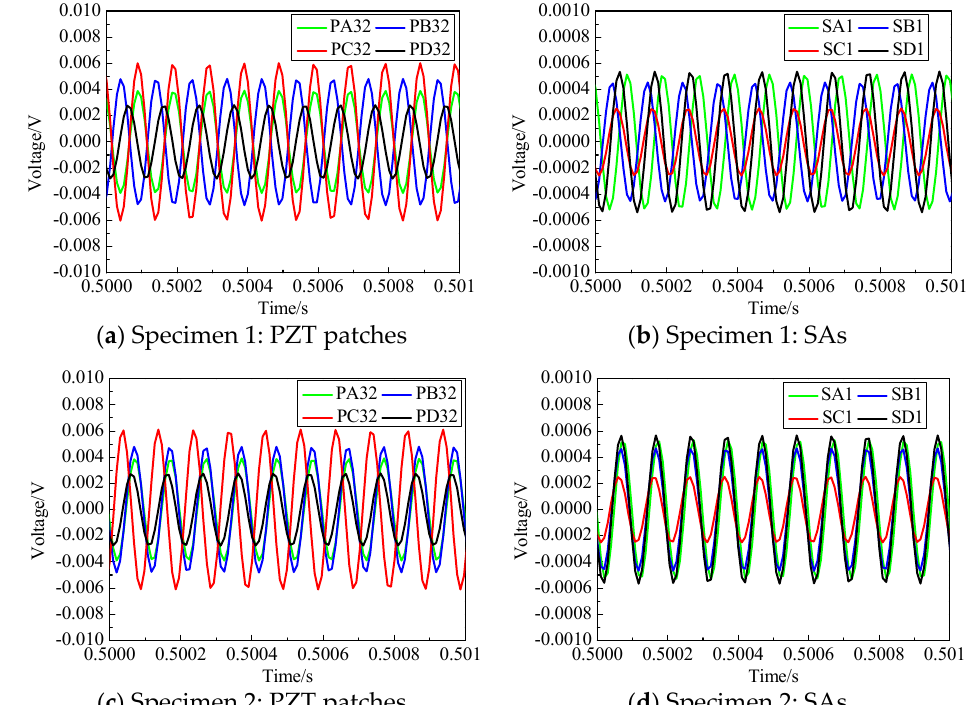
Figure 7. Voltages measurement of selected PZT patches and SAs in each side of tested specimens.